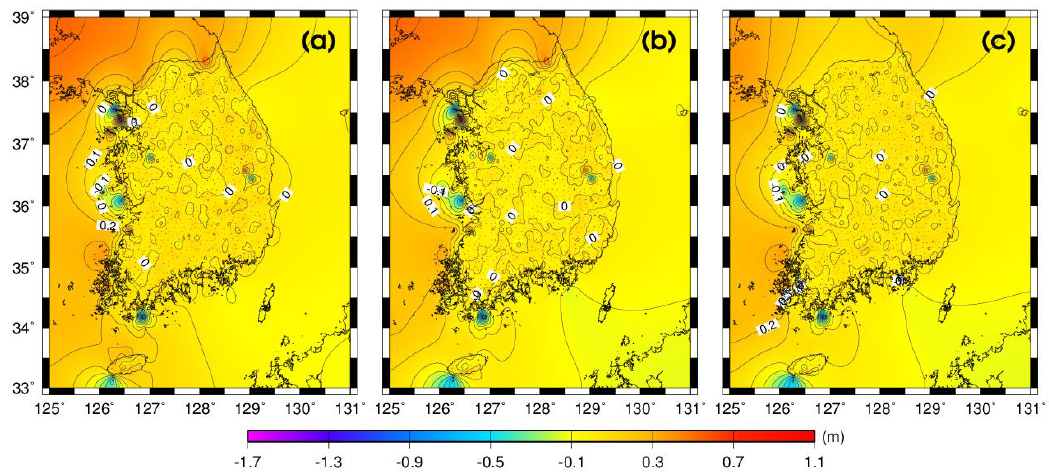
Figure 6. Residual surface maps between the GNSS/leveling-derived geoid heights (𝑁 𝐺𝑁𝑆𝑆/𝑙𝑒𝑣𝑒𝑙𝑖𝑛𝑔 ) on the 1182 UCPs and those (𝑁 𝐾𝑁𝐺𝑒𝑜𝑖𝑑 ) derived from the three KNGeoid models. ( a ) KNGeoid13; ( b ) KNGeoid14; and ( c ) KNGeoid18. The red dots represent the locations of the 1182 GNSS/leveling UCPs. The statistics of the differences between the geometric geoid heights derived from GNSS/leveling on the 1182 UCPs and the geoid heights derived from the three KNGeoid models are represented as shown in Table 5. The differences between the GNSS/leveling geoid heights and the KNGeoid18 geoid heights represent good agreement with the smallest RMSE (10.3 cm) in Table 5. Table 5. Statistics of the differences between the geoid heights (𝑁 𝐺𝑁𝑆𝑆/𝑙𝑒𝑣𝑒𝑙𝑖𝑛𝑔 ) derived from the GNSS/leveling on the 1182 UCPs and those (𝑁 𝐾𝑁𝐺𝑒𝑜𝑖𝑑 ) derived from the three KNGeoid models (unit: m). Min. Max. Mean Std. dev.